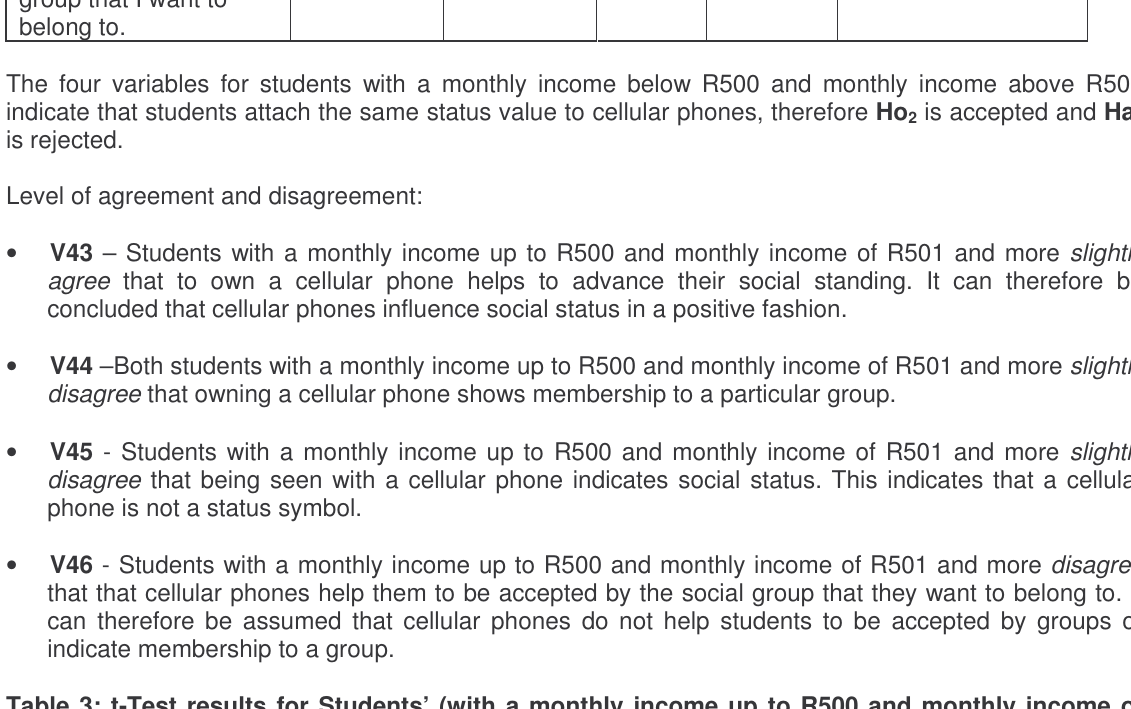
Table 3: t-Test results for Students’ (with a monthly income up to R500 and monthly income of R501 and more) perception of the relationship between network operator and service